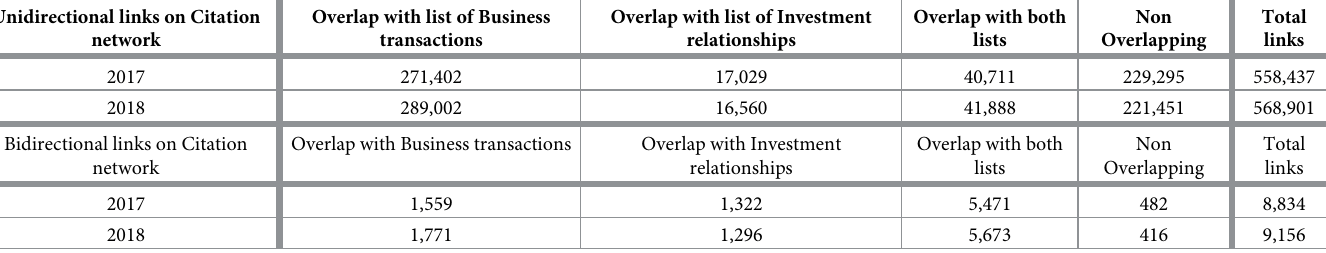
Table 5. Number of overlapping links among links on the citation network, list of inter-firm business transactions and list of inter-firm investment relationships. Unidirectional links on Citation